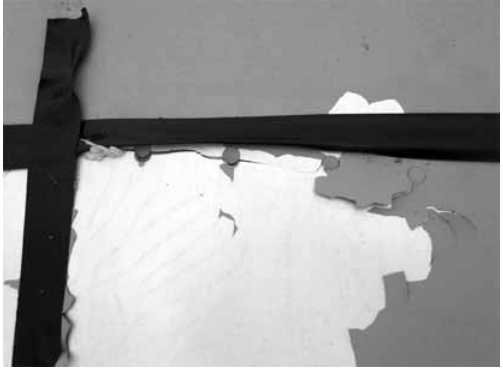
Fig. 28. Close-up view of skin crack after thin shield test.